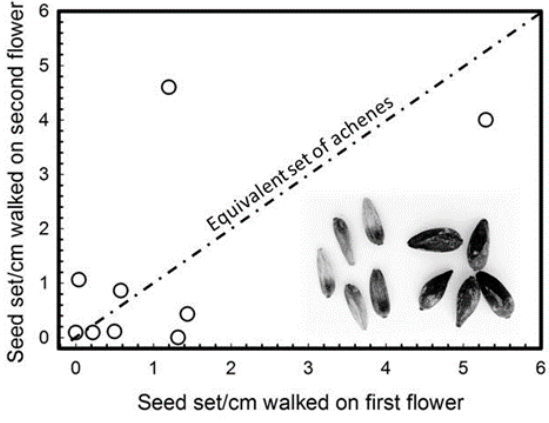
F IGURE 4. Scatterplot for the numbers of filled achenes set per cm walked by the nine female O. californica that visited two flowerheads sequentially, comparing the first visited flowerhead (x- axis) with the second (y-axis). Points below the dashed line indicate diminishing returns at the second flower. Inset Image comparing plump achenes filled with endosperm that were counted in these experiments (right) versus thin, flexible empty